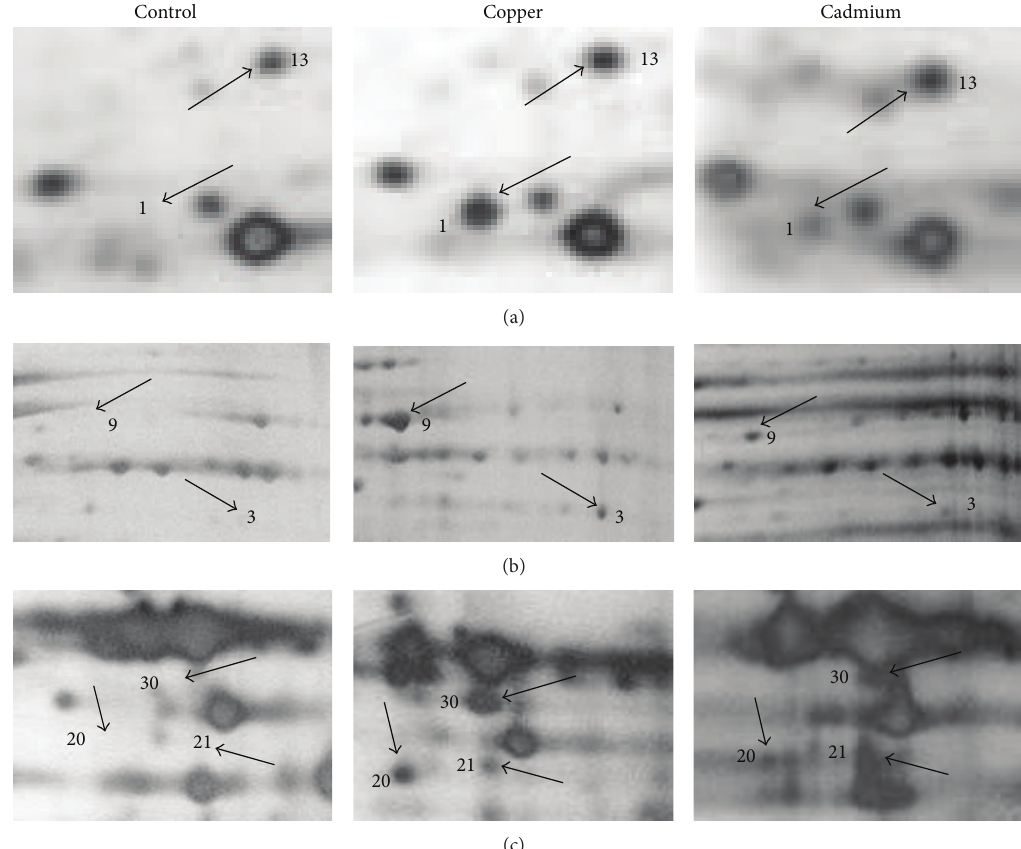
Figure 3: Comparison of selected proteins of S. metallicus cells treated with Cu or Cd. Protein extracts were obtained from cells treated without metals and with 100mM Cu or 1mM Cd for 24 h and the proteins were separated by 2D-PAGE. The segments (a), (b), and (c) are the enlarged dashed boxes in Figure 2 under the three conditions indicated. Numbers show some of the spots with increased intensity in cells treated with Cu or